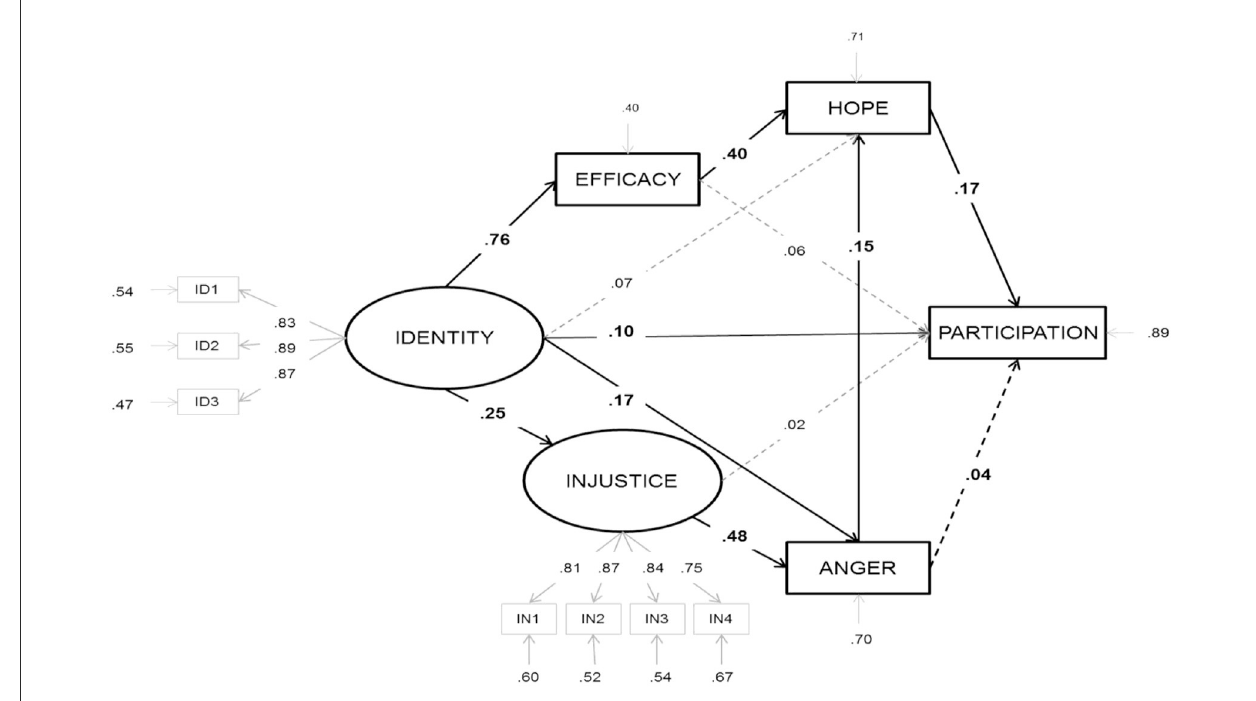
FIGURE6 SIMCA model integrating emotions. Source: Wlodarczyk et al. (2017).